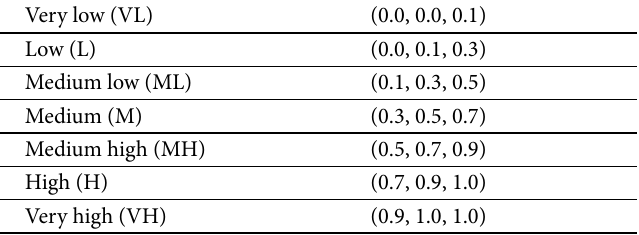
Table 1. Linguistic variables for the importance weight of each criterion